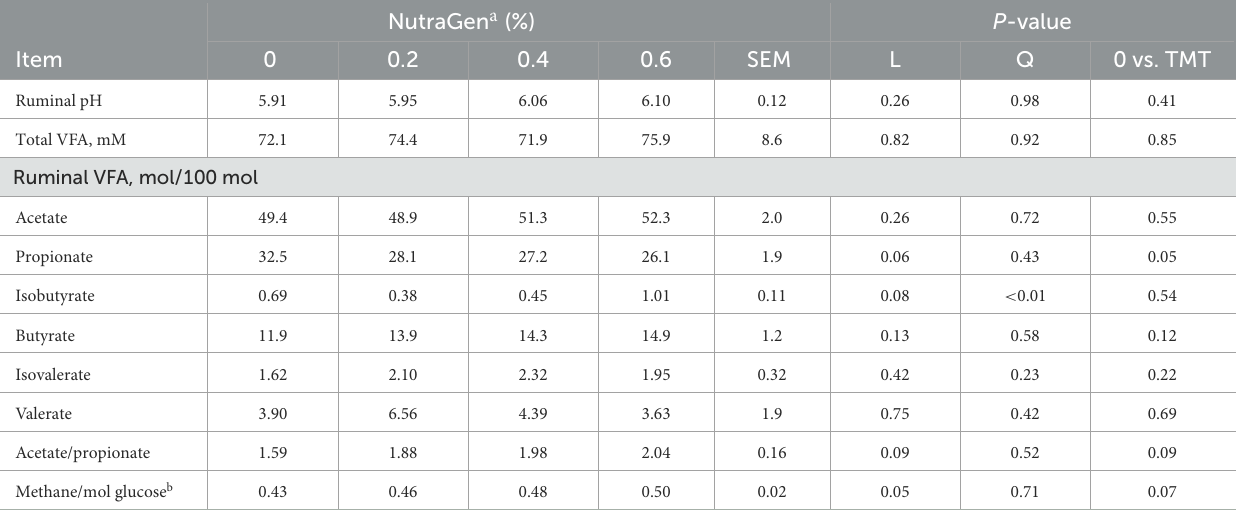
TABLE 6 Effects of feeding NutraGen supplement on ruminal pH and VFA